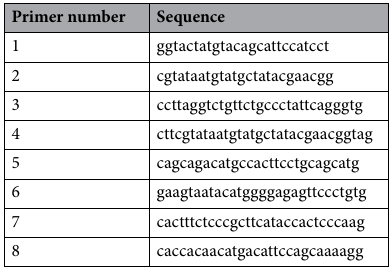
Table 2. Primer sequences used in this